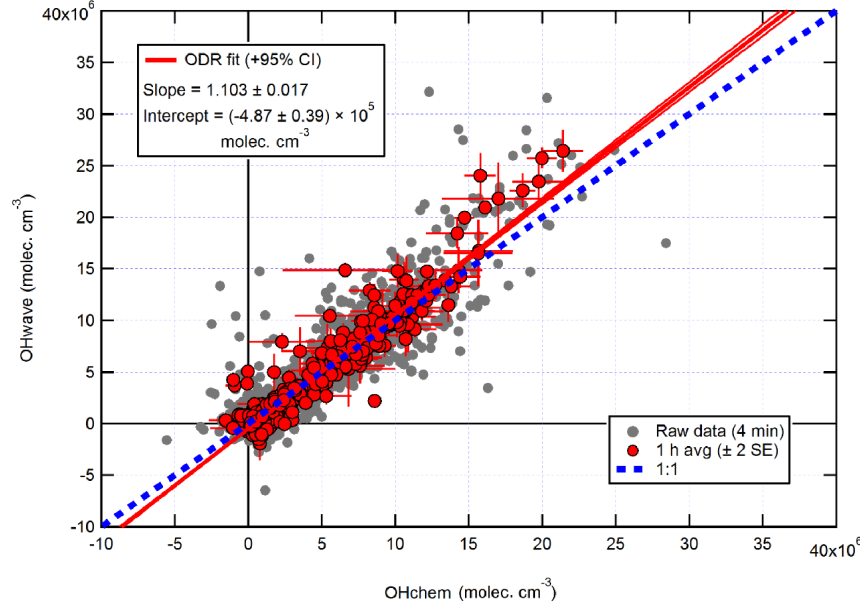
Figure 14. Overall intercomparison of OH wave and OH chem observations from the summer 2017 AIRPRO campaign. Grey markers represent raw data (4min), with 1h averages ( ± 2 SE) in red. The thick red line is the ODR fit to the hourly data, with its 95% CI bands given by the thin red lines; fit errors are given at the 2 σ level. For comparison, 1 : 1 agreement is denoted by the dashed blue line. OH wave data were corrected for the known interference from O 3 + H 2 O.